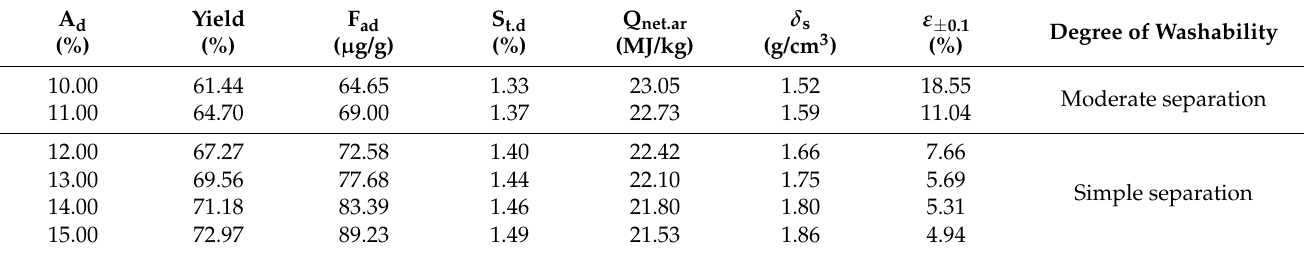
Table 3. The degrees of washability of clean coal at the different given ash contents 1 .